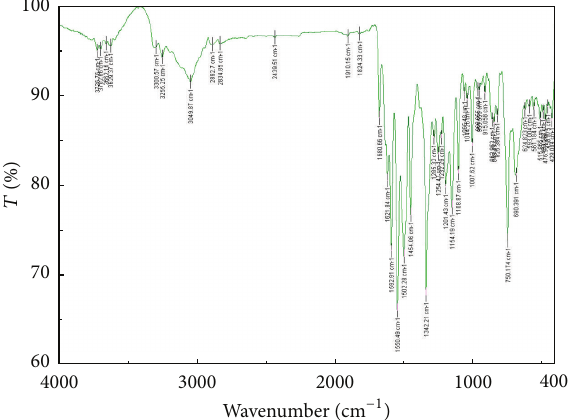
Figure 3: IR spectra for Naphthol AS-D pigment.